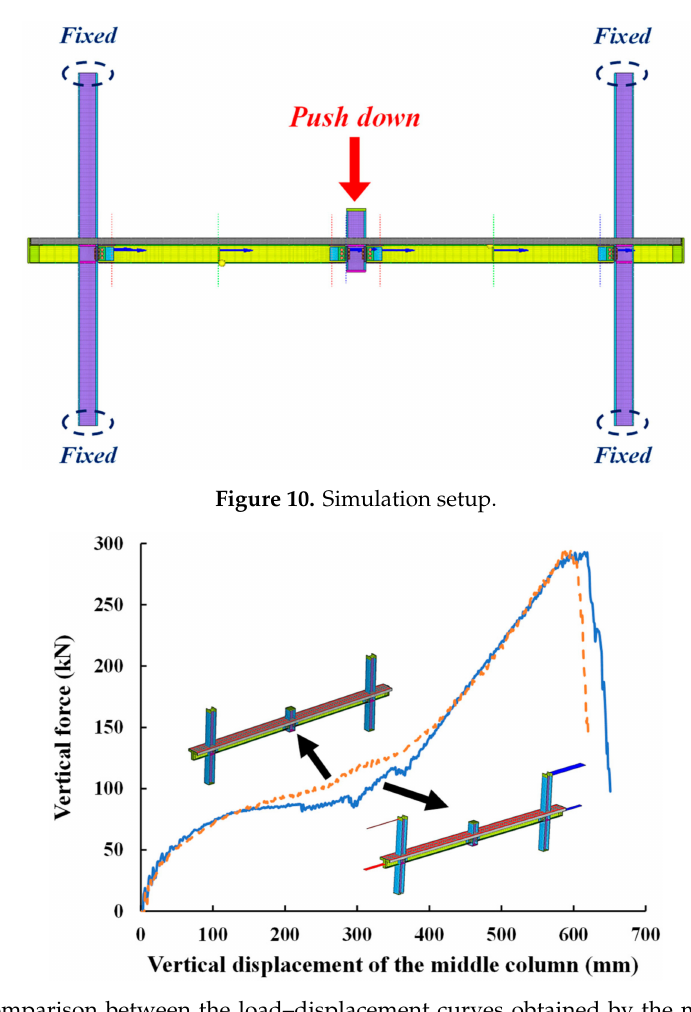
Figure 11. Comparison between the load–displacement curves obtained by the models with and without discrete elements connected the ends of the